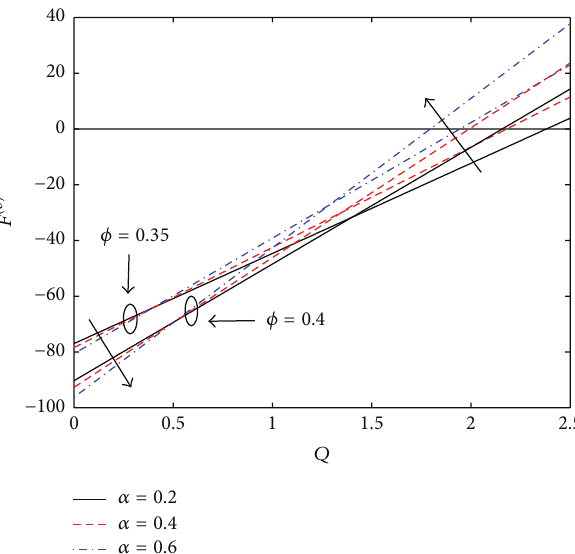
Figure 11: Frictional force on the outer tube 𝐹 (𝑜) versus the time- averaged flow rate 𝑄 for different values of heat parameter 𝛽 and the Grashof number Gr with 𝜆 1 = 1 , 𝛼 1 = 0.4 , 𝜀 = 0.35 , 𝜙 = 0.4 , and 𝑡 = 1 .